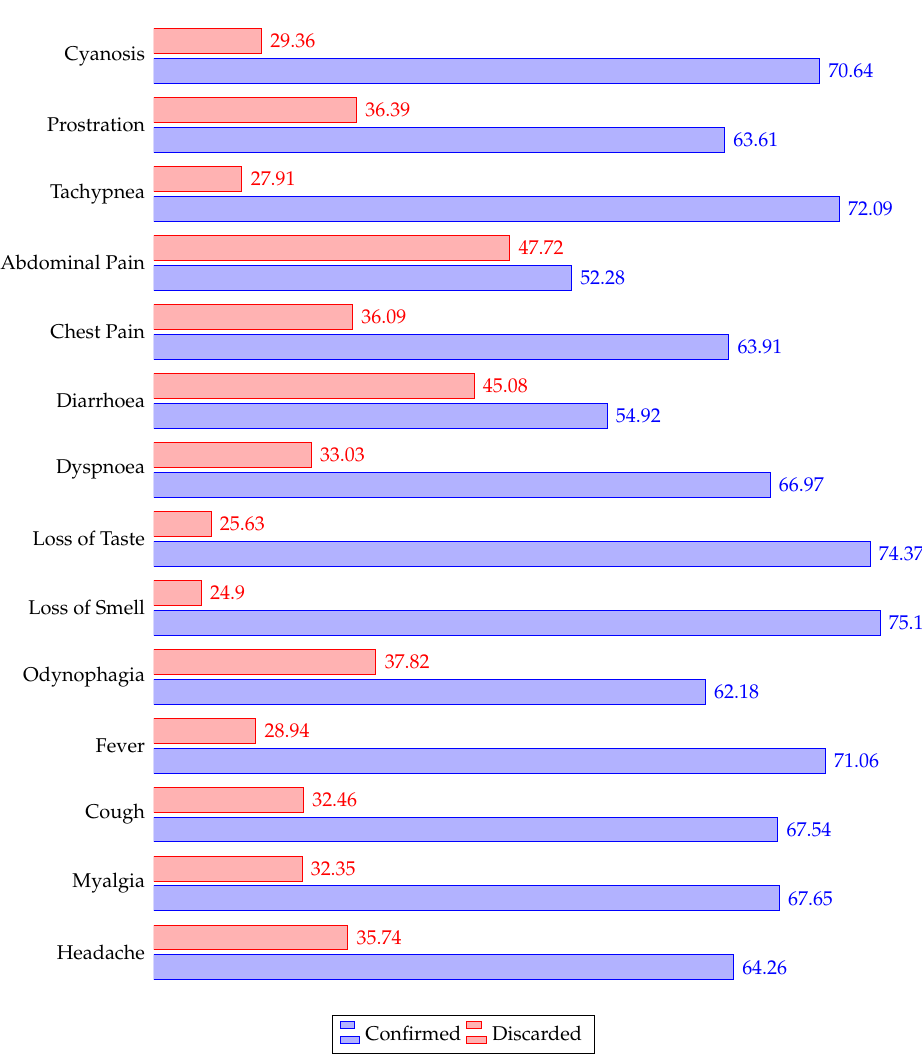
Figure 6. Relative frequency (percentage) of symptoms in confirmed and discarded